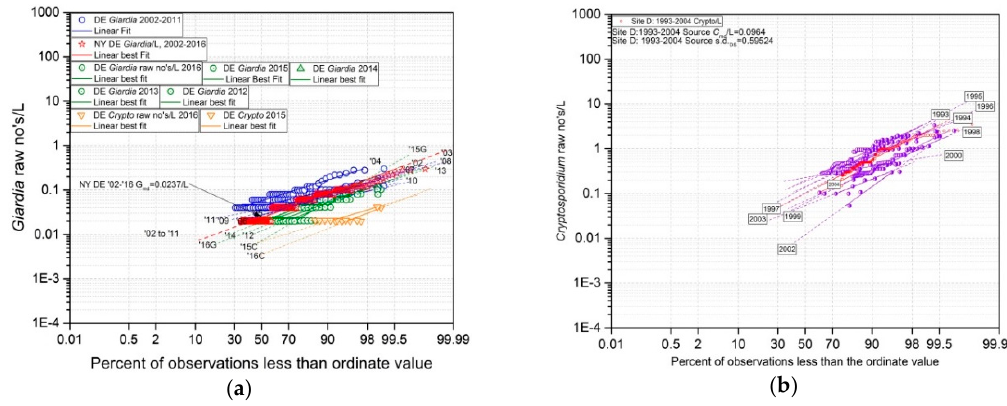
Figure 2. Cumulative frequency plots of C&G monitoring data: ( a ) 9 yearly records of Cryptosporidium measurements in 10 L river water samples (see Figure 1b,c); and ( b ) Giardia measurements in 50 L reservoir water samples from monitoring 2002–2016.